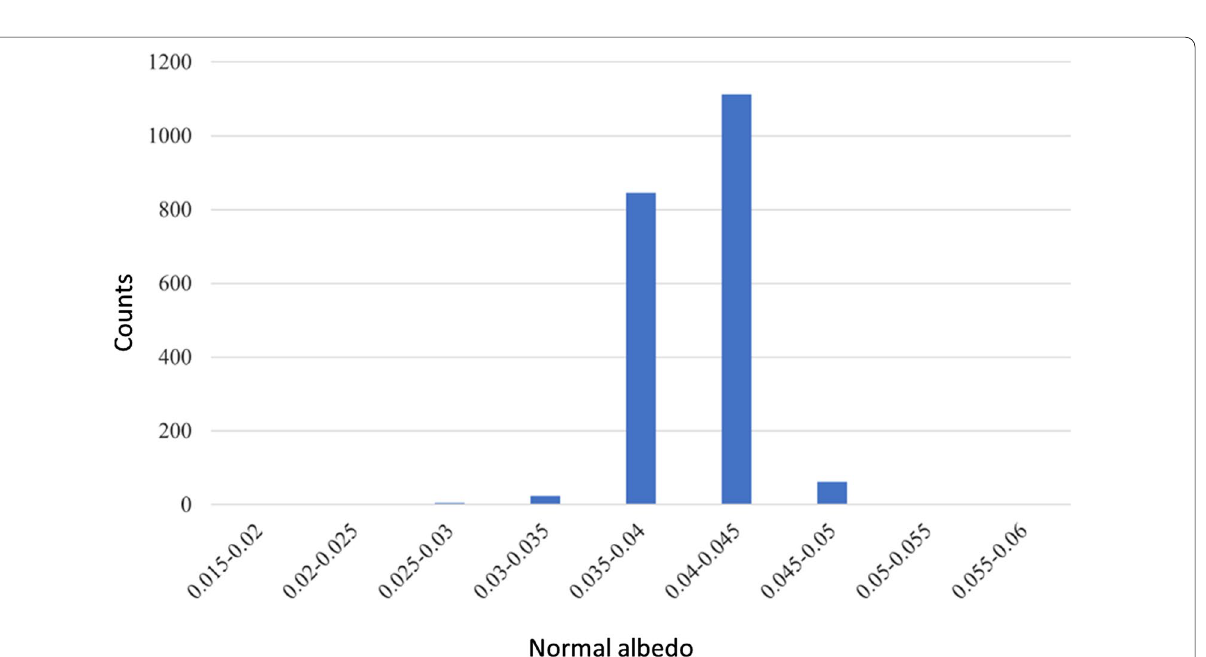
Fig. 16 Histogram of the normal albedo map shown in Fig.